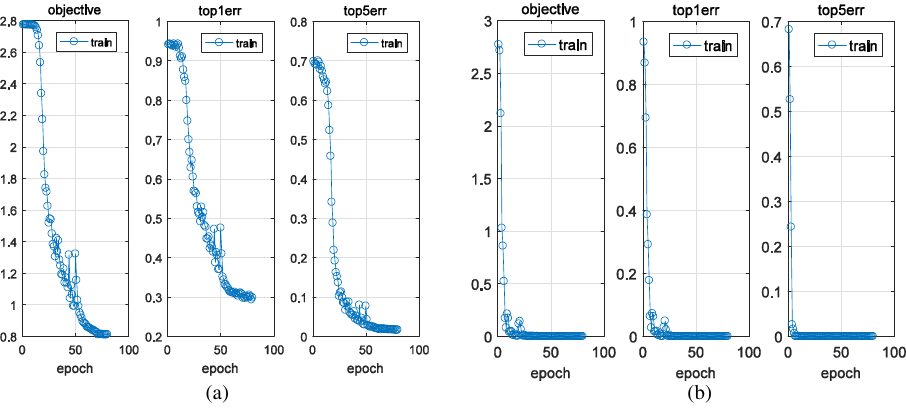
Figure 14. Training results: ( a ) SAR-CNN; ( b )